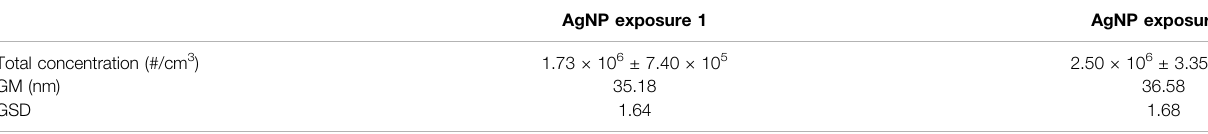
(mean ± S. D), GM, geometric mean; geometric standard deviation.